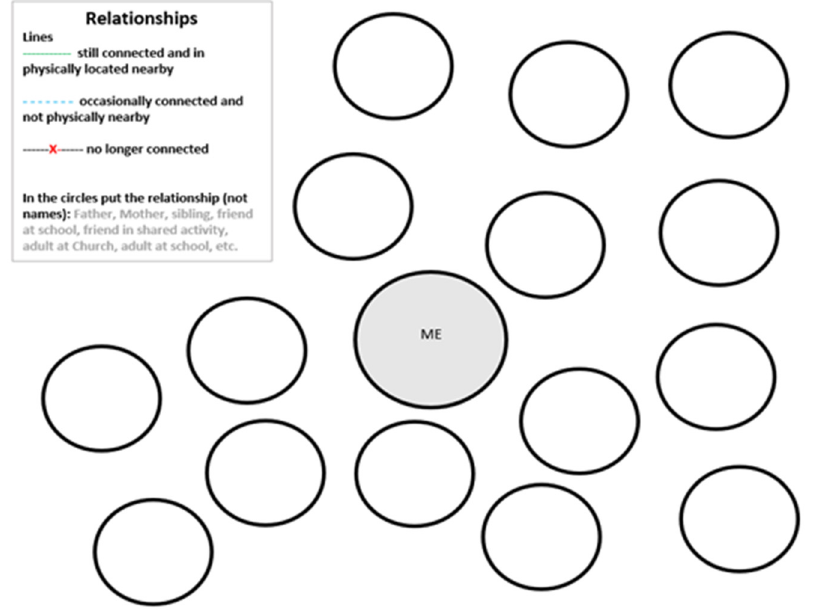
Figure A2. The Figure A2. The eco-map.